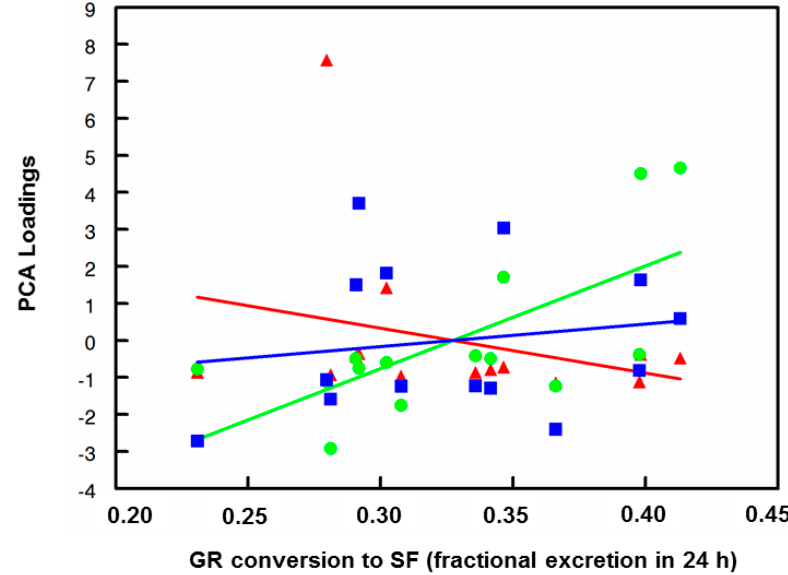
Figure 4. Principal component analysis (PCA) loadings and sulforaphane bioavailability (means following single pre- and post-omeprazole delivery of an oral BSE dose containing GR and active myrosinase). PC1( ▲ ), PC2 ( ● ), PC3( ■ ).